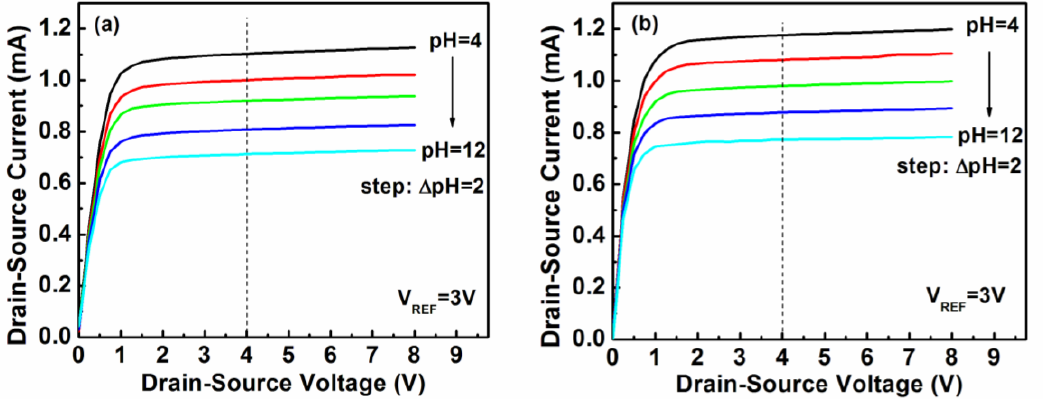
Figure 3. Drain-source current—drain-source voltage characteristics of the